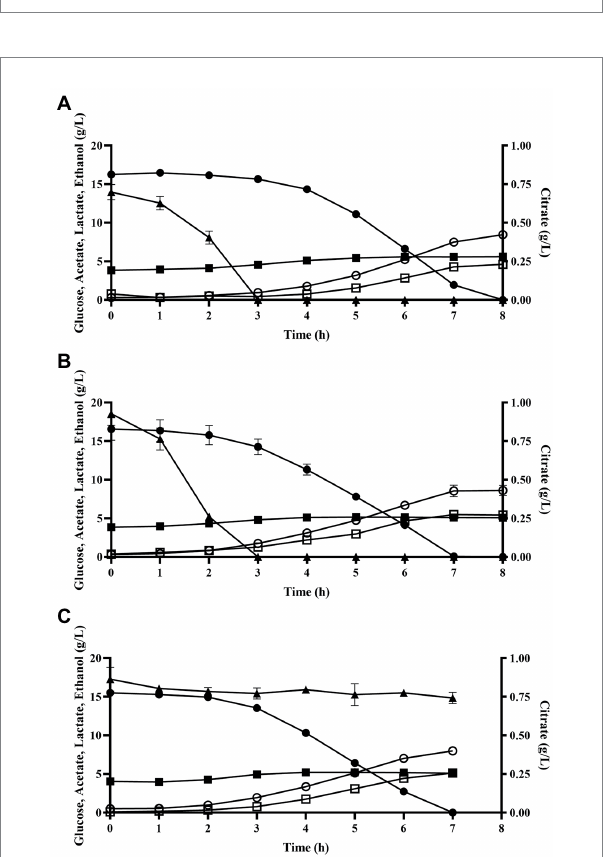
FIGURE 3 Metabolic profile for batch cultivation in 2 L bioreactors for the three conditions. (A) Air sparged, (B) non-sparged, and (C) N 2 sparged. Data are mean ± SD of three biological replicates for 3 conditions. Glucose (filled circle), acetate (filled square), lactate (open circle), ethanol (open square), citrate (filled triangle).